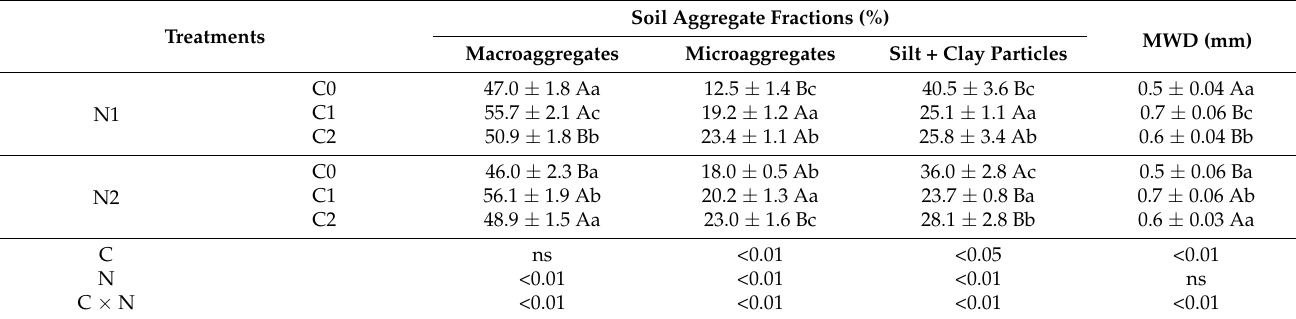
Note: Macroaggregates (0.25–2.0 mm), microaggregates (0.053–0.25 mm), silt and clay particles Table 2. Stability and size distribution of soil aggregates. (<0.053 mm) and mean weight diameter (MWD). The different lowercase letters indicate significant difference among straw input amounts of the same N application at p < 0.05. Different capital letters indicate a significant difference among N application amounts of the same straw input at p < 0.05.